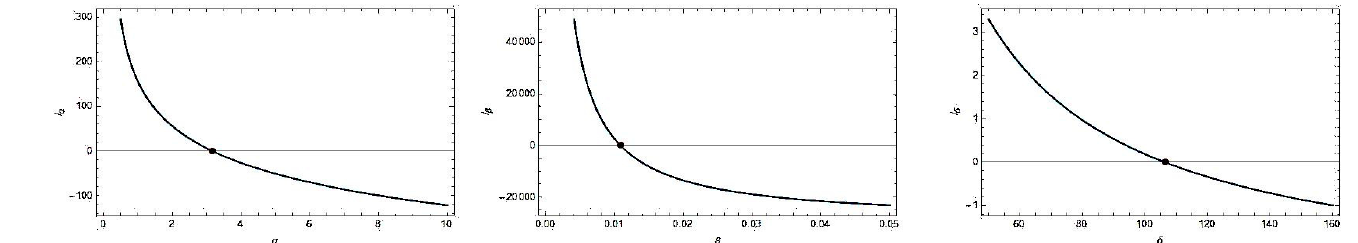
Figure 8. Existence and uniqueness plots for 3PB model parameters for burr data set.